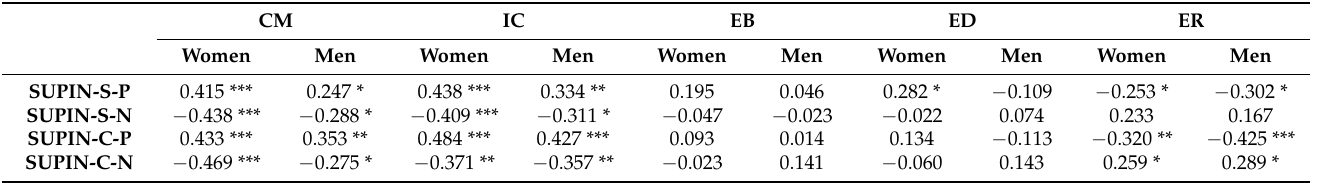
Table 14. Pearson’s r correlation coefficients between the intensity of positive and negative emotions and the dimensions of identity.